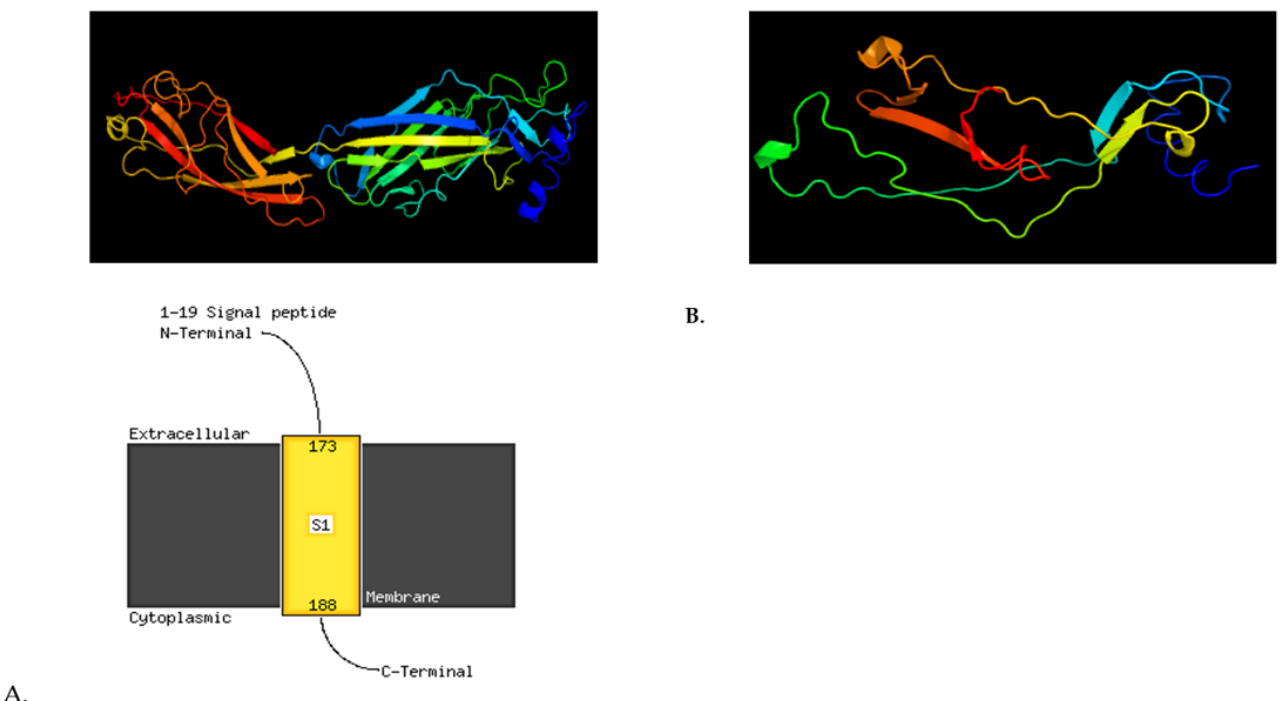
Figure 6. 3D viewing of the protein model with premature STOP codon. ( A ). IpfD LT2 (359 aa); ( B ). IpfD 69M (134 aa), the truncated IpfD protein with loss of transmembrane structure. Created by Phyre2, Protein Homology/analogY Recognition Engine V 2.0, London,